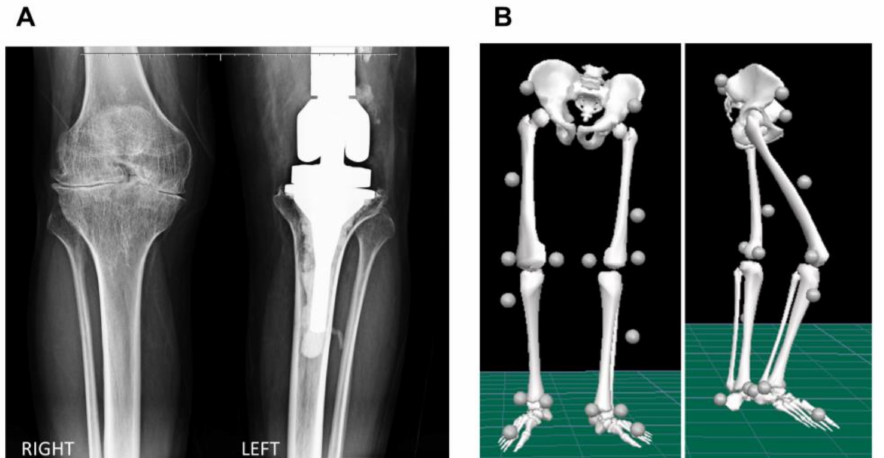
Figure 1. ( A ) Standing anterior–posterior radiographic view of the right and left knees, and ( B ) frontal and sagittal view of the biomechanical model displaying the marker set convention adopted in the